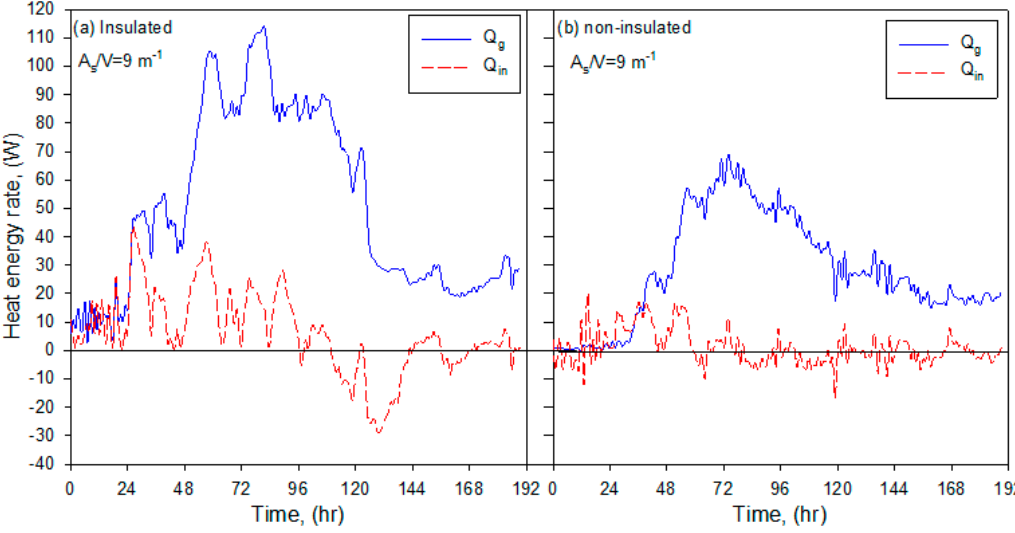
Figure 8. Time course of total heat generation rate ( Q g ) and rate of change of internal energy ( Q in ) of compost were estimated in the ( a ) insulated and ( b ) non-insulated bioreactor during the composting process.